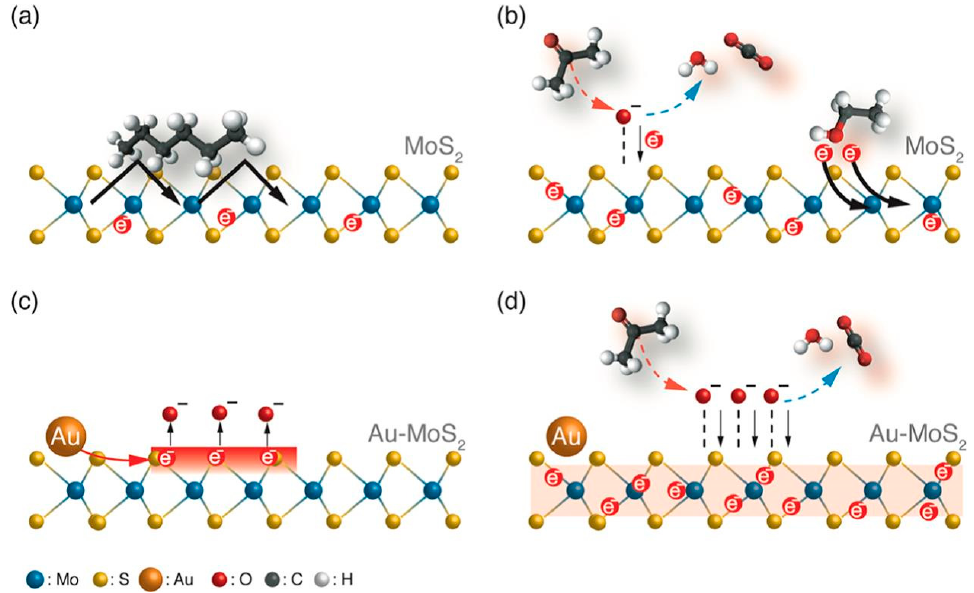
Figure 10. Schematic representation of Au-MoS 2 nano-flakes sensing mechanisms for ( a ) hydrocar- bons using MoS 2 , leading to small signal alternation, due to dipole scattering through the electron clouds of –CH 2 – groups; ( b ) oxygen-based VOCs using MoS 2 , which donate electrons to the MoS 2 ( left ) and are oxidized by the adsorbed oxygen species, releasing electrons to MoS 2 ( right ); ( c ) oxy- gen-based VOCs using MoS 2 decorated with Au NPs, which increase electron concentration and, thus, oxygen species adsorption on MoS 2 ; ( d ) returning more electrons upon interaction with the oxygen-based VOCs. Reprinted with permission from ref. [69]. Copyright © 2019, American Chem- ical Society.